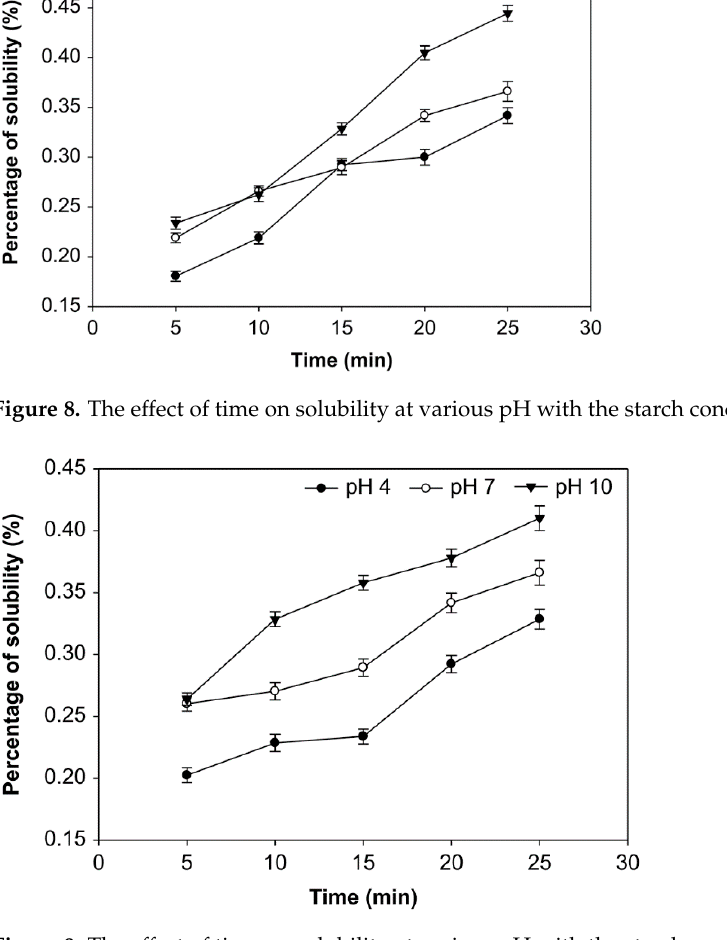
Figure 9. The effect of time on solubility at various pH with the starch concentration of 30% ( v / w ).